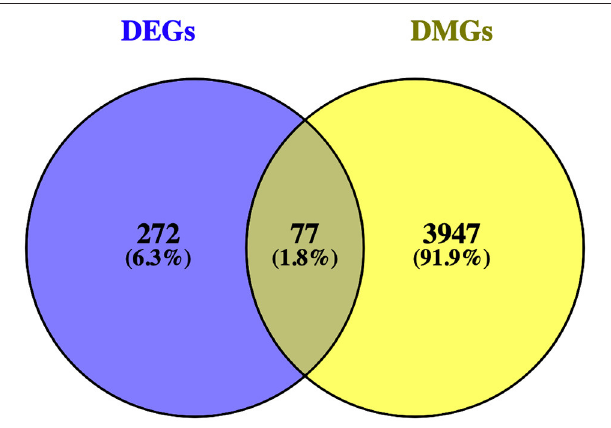
FIGURE 3 | Venn diagram showing the intersection of differentially expressed genes (DEGs) and differentially methylated genes (DMGs).